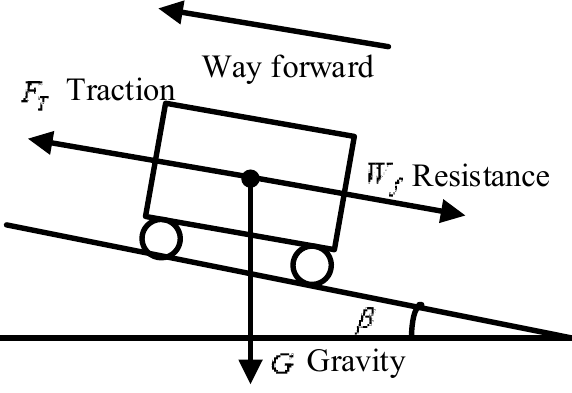
Figure 1. Stress model of rail transit.